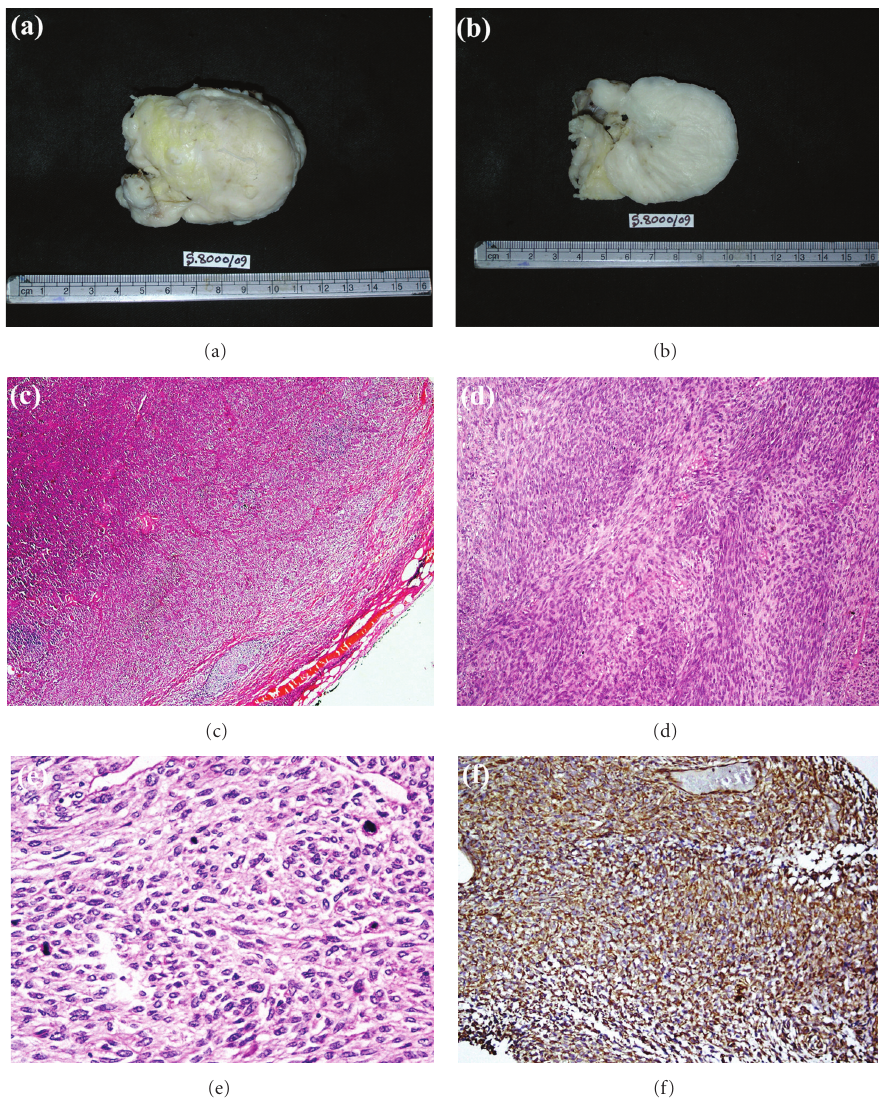
Figure 1: Gross photographs showing the external aspect (a) and cut surface (b) of the specimen showing a well-circumscribed and encapsulated mass with a thin rim of breast parenchyma surrounding it. The tumor is homogenous, whitish with areas of myxoid change. (c, d, e) Progressive increasing magnification of histology (40x, 100x and 400x) showing the well-encapsulated mass composed of intersecting fascicles of spindle cells with frequent mitoses. (f) Peroxidase-based immunohistochemistry for smooth muscle actin (SMA) showing di ff use, strong cytoplasmic